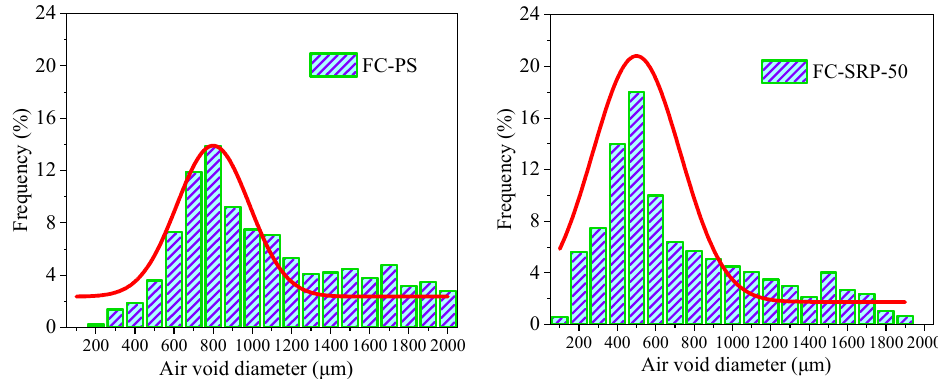
Figure 11. Aperture distributions of foam concrete group.